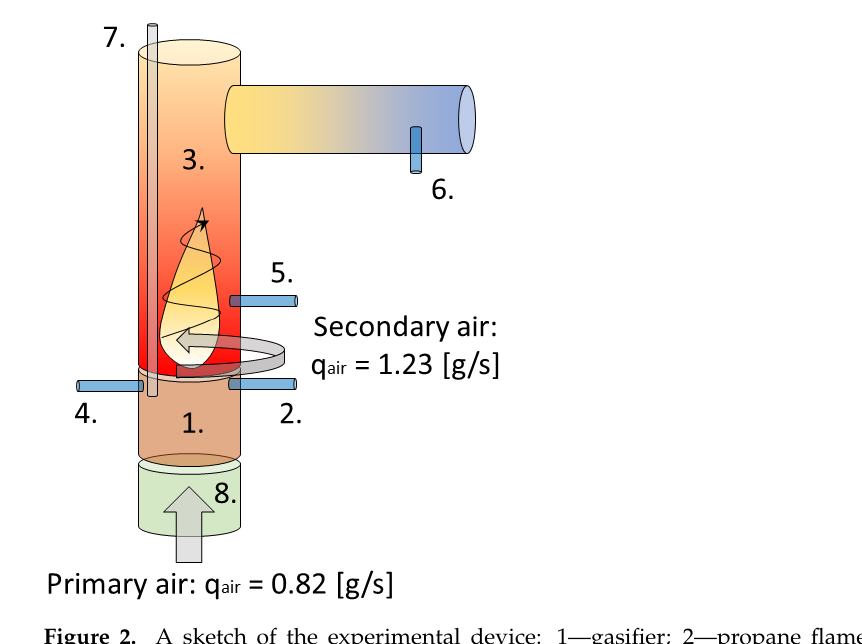
Figure 2. A sketch of the experimental device: 1—gasifier; 2—propane flame supply nozzle; 3—combustion chamber; 4—orifice for gasification products measurements; 5—orifice for flame temperature measurements; 6—orifice for combustion products measurements; 7—fuel level measurement rod; 8—primary air inlet.